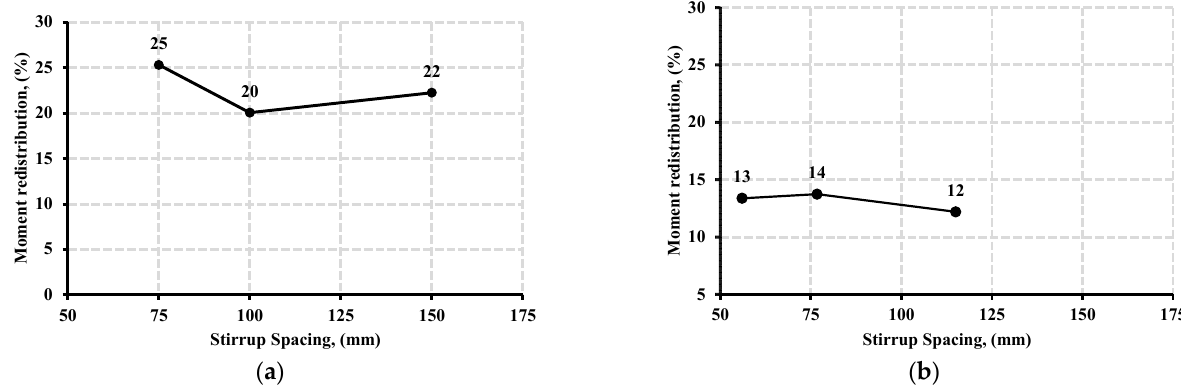
Figure 12. The relationship between the moment redistribution and stirrup spacing for beams specimens with concrete strength of ( a ) 40 MPa, and ( b ) 80 MPa.